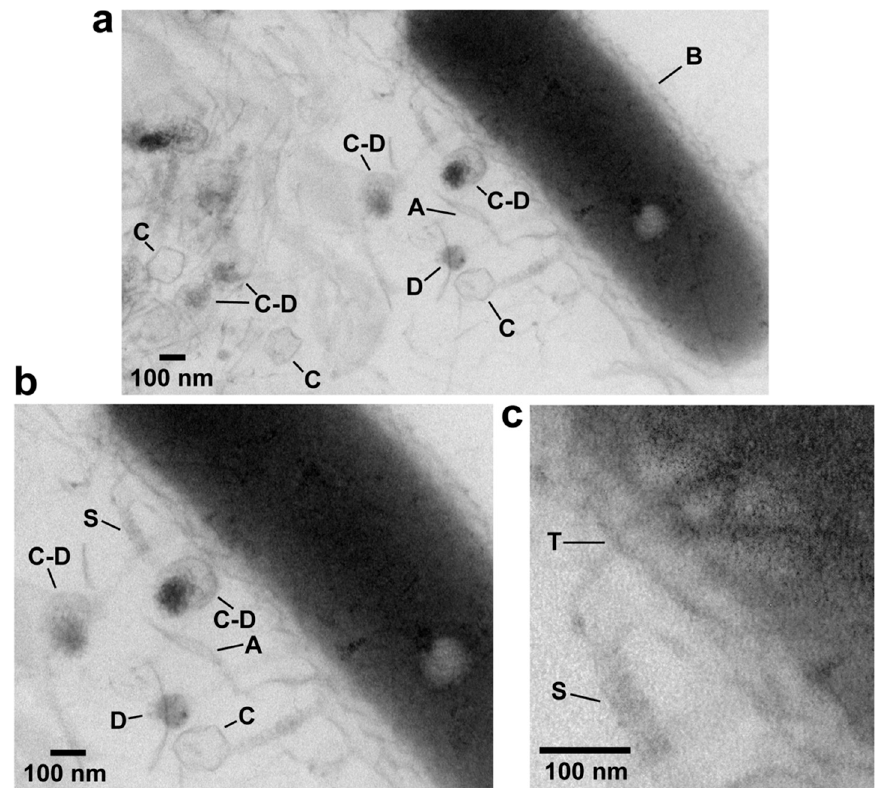
Figure 3. EM-TS of a phage G plaque. The procedure of reference 28 was used to embed, thin section and perform electron microcopy of a plaque of phage G. ( a ) A field at relatively low magnification, ( b ) a region within the same field at higher magnification, ( c ) a region of the field of ( b ) at higher magnification and with increase in contrast. A, agarose fiber; C, capsid; D, condensed DNA; S, tail sheath; T, tail tube; B, bacterial cell.